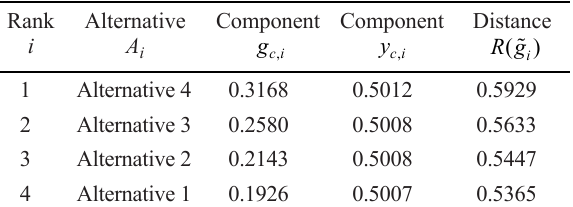
Table 7. Ranking of alternatives according to the distance )~ ( of the original point to the centroid point i gR